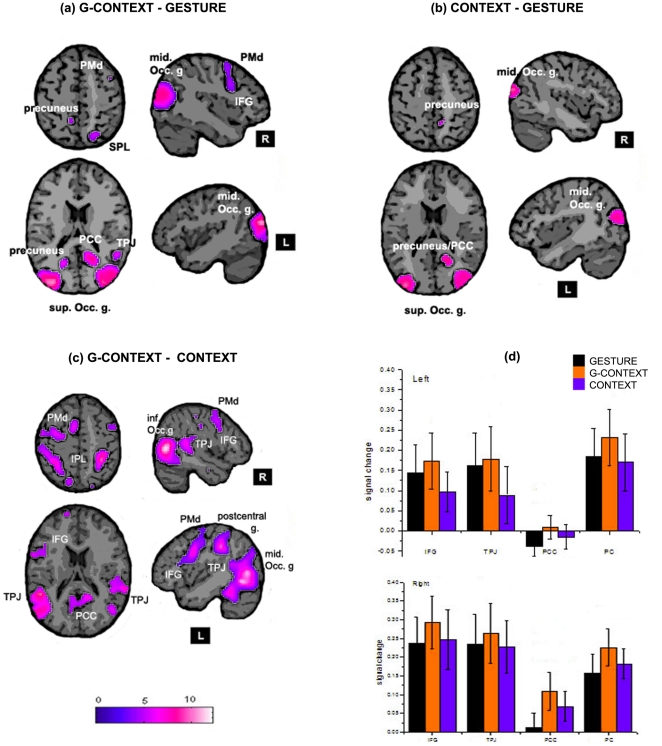
Subtraction analysis.Signal increase for (a) G-CONTEXT – GESTURE; (b) CONTEXT – GESTURE and (c) G-CONTEXT – GESTURE. The coordinates of the planes shown are z = 53 (top axial planes); z = 18 (bottom axial planes); x = −43 (top sagital planes); x = 43 (botton sagital planes). The most relevant regions are labelled. (d) BOLD signal for the three conditions and both hemispheres. In Black: GESTURE, Orange: G-CONTEXT and Blue: CONTEXT. up) Left hemisphere; down) Right hemisphere.